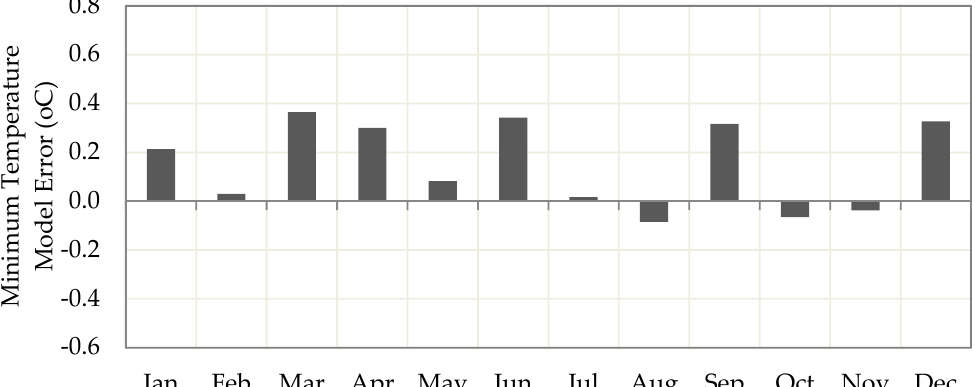
Figure 2. CanESM2 model error of maximum temperature for the baseline period (1961–1990).